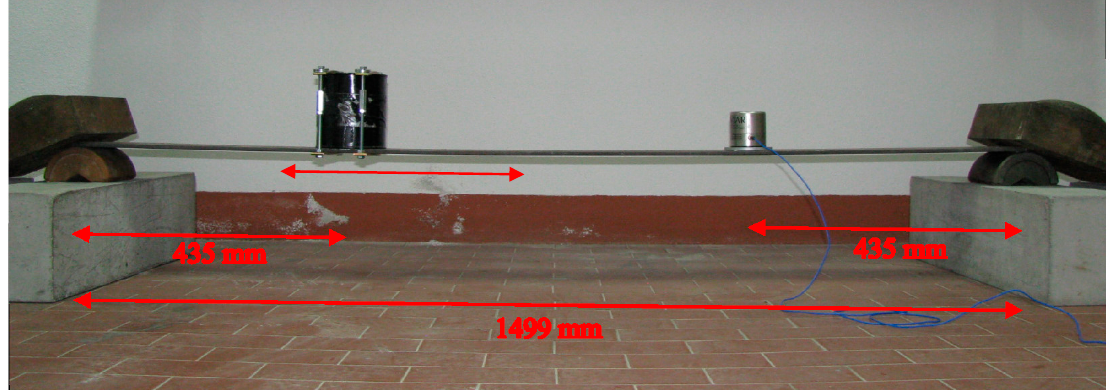
Figure 4. Simply supported beam experimental test scheme. The vibrodyne is on the left, while the accelerometer is on the right.